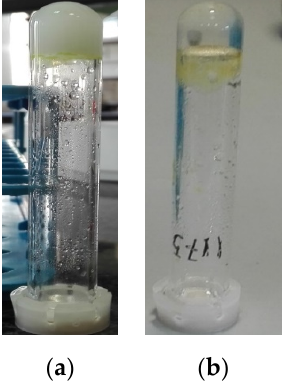
Figure 5. Pictures of hydrogels: ( a ) compound 2e; ( b ) compound 2h.